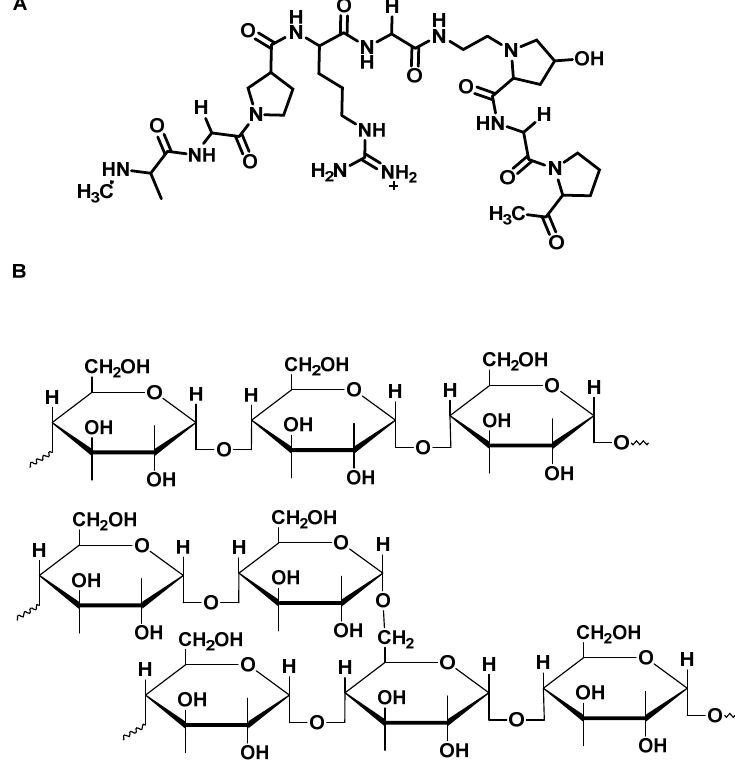
Scheme 1. Chemical structure of ( A ) gelatin and ( B ) cassava starch.